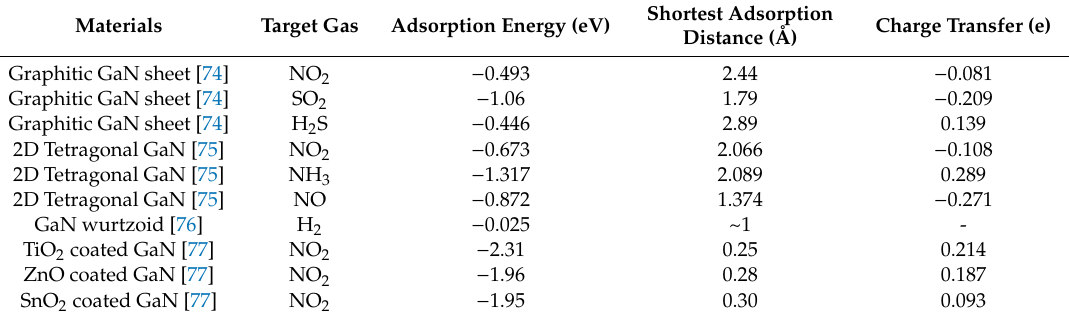
Table 5. The adsorption energy (eV), shortest adsorption distance (Å) and charge transfer (e) between gas molecules and GaN sensors at the most stable adsorption configuration based on